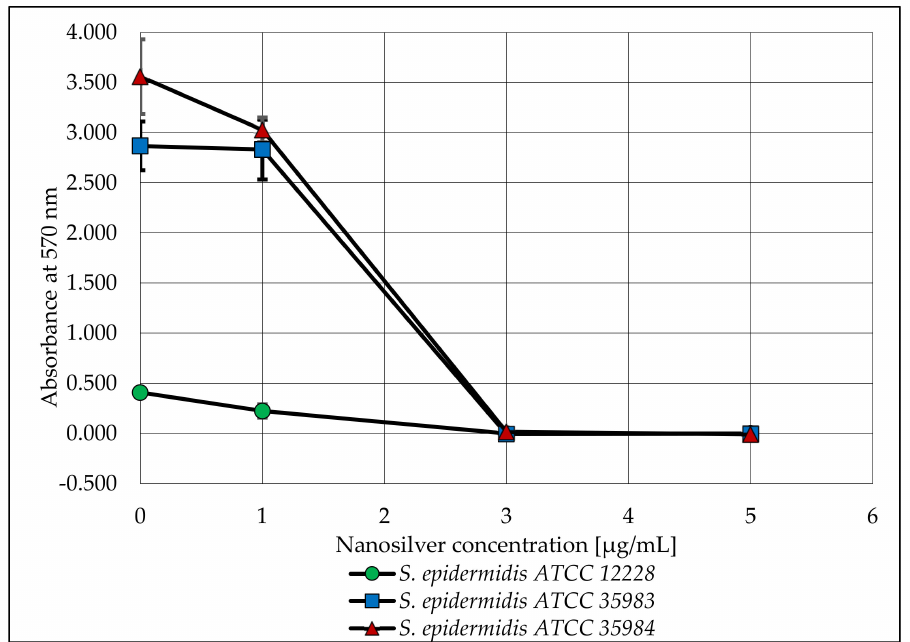
Figure 4. The ability of S. epidermidis strains to produce biofilm after exposure to various concentra- tions of AgNPs with a particle size of 10 nm. Error bars indicate standard deviations.